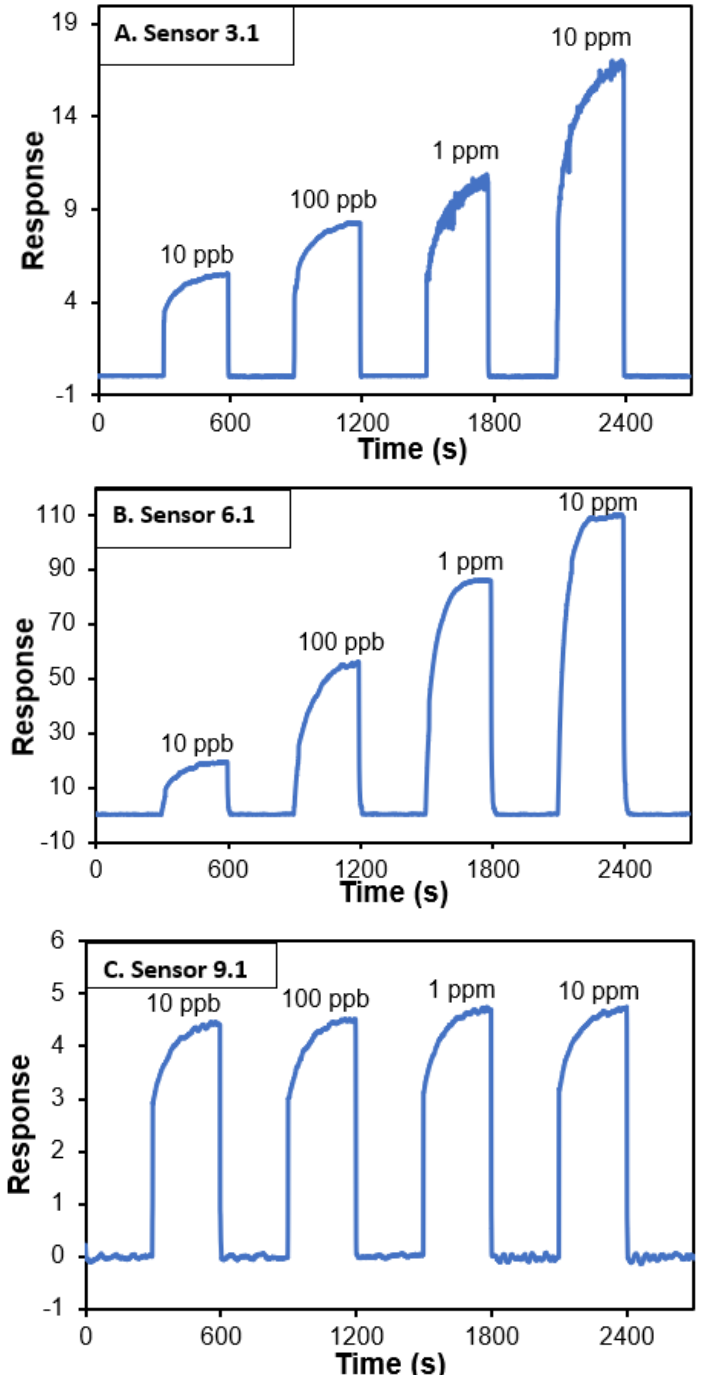
Figure 2. Responses of gold nanoparticle (AuNP) sensors derived from ( A ) N-alkoxy-N’-t-butyl urea 3.1, ( B ) N-alkyl-N’-t-butyl urea 6.1, and ( C ) N-alkoxy-N’-t-butoxy urea 9.1 for sensing acetone from 10 ppb to 10 ppm.